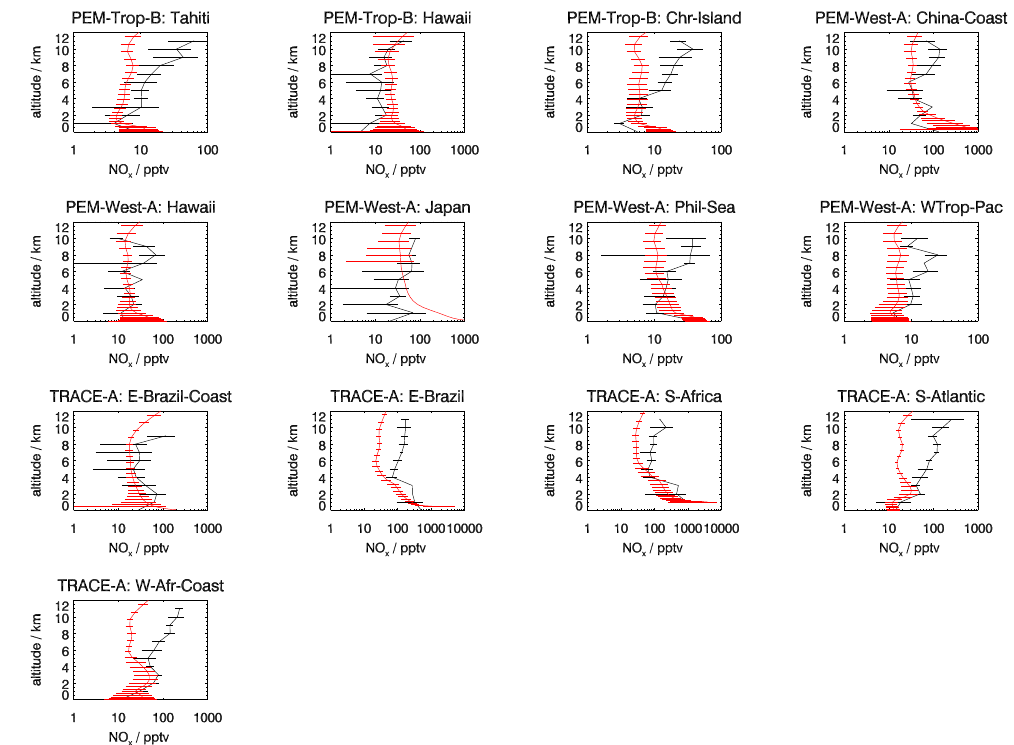
Fig. 19. Comparison between regional vertical profiles of modelled (red) and observed (black) NO x from various aircraft campaigns compiled into data composites by Emmons et al. (2000). In each case, the mean concentration in each altitude bin is plotted and the horizontal lines represent the mean ± 1 standard deviation.